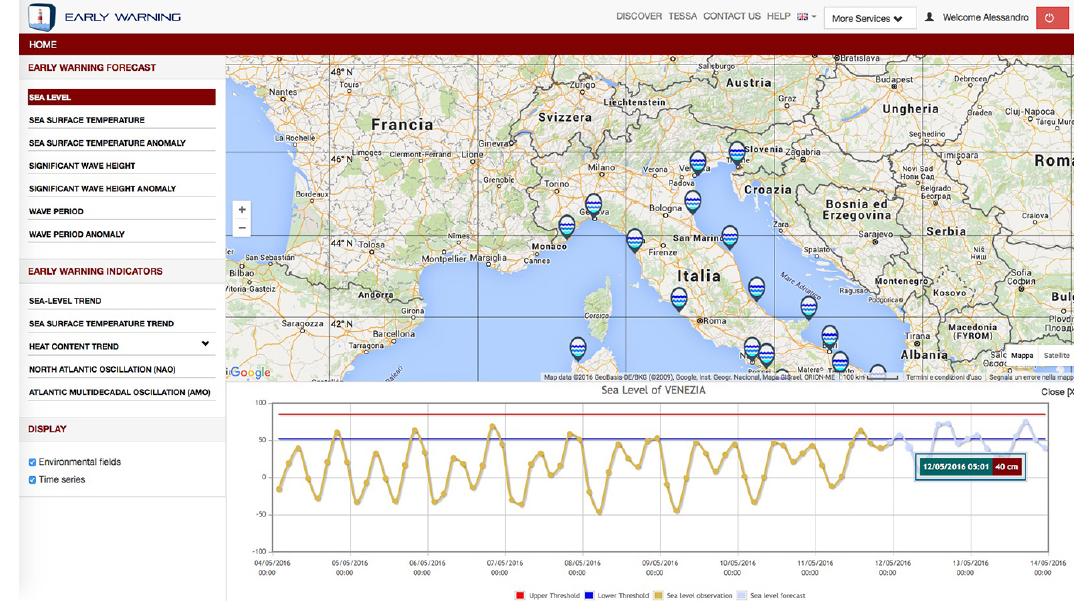
Figure 9. EarlyWarning forecast for the sea level of